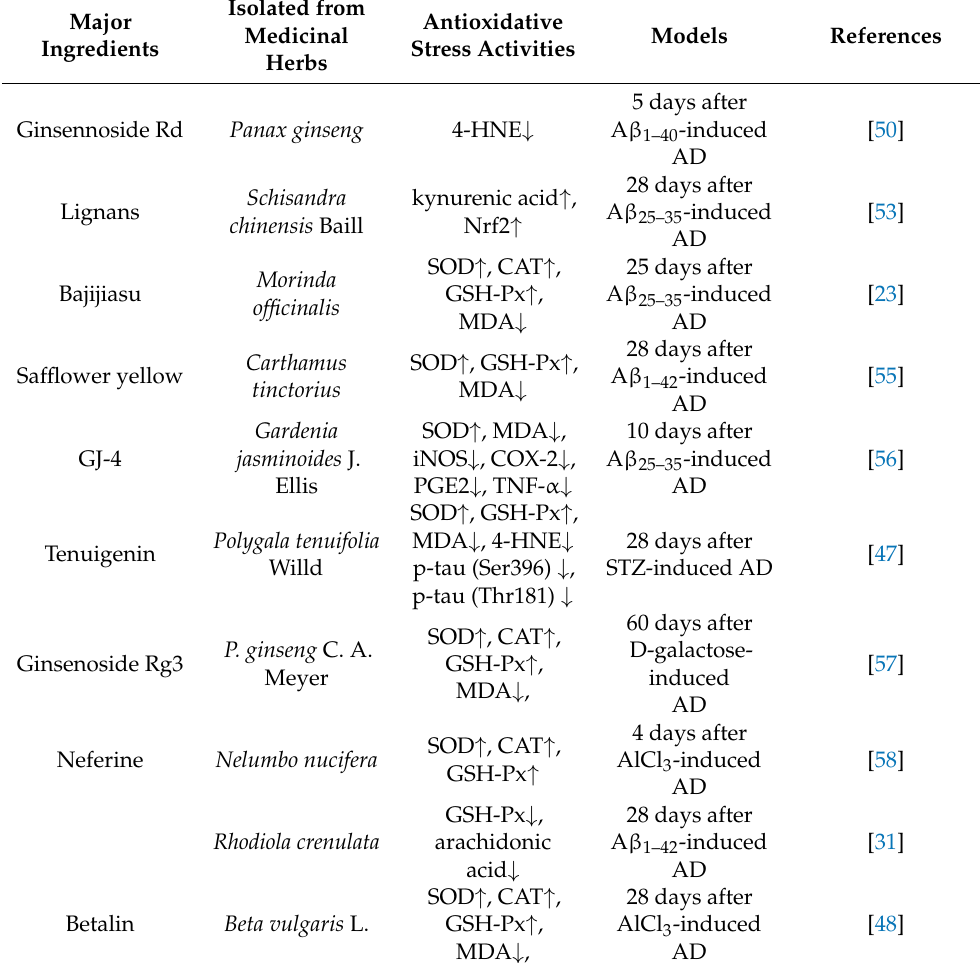
Table 2. MHDIs that inhibit A β -induced oxidative stress in AD animal